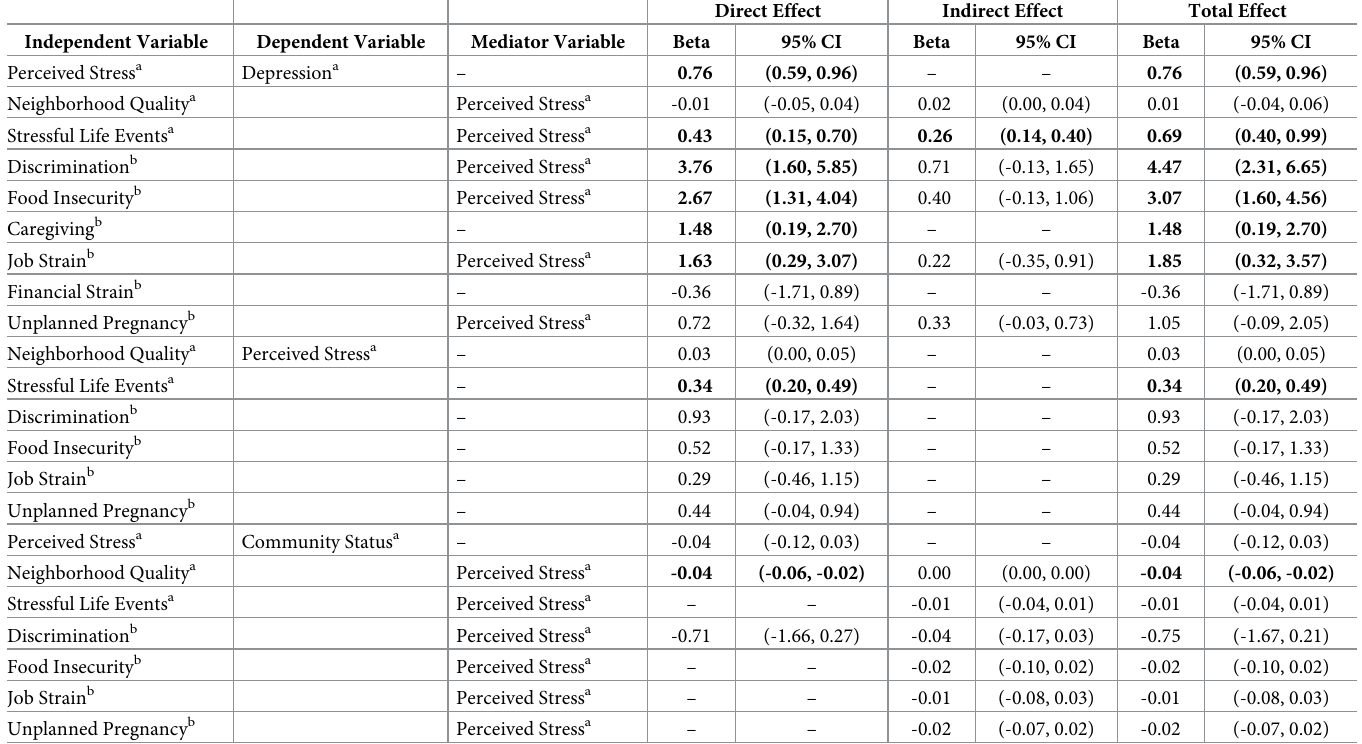
Table 3. Regression coefficients and 95% confidence intervals for direct, indirect, and total effects between psychosocial stress measures in the Chemicals in Our Bodies-2 cohort (N = 510). Model has good fit (RMSEA = 0.04, SRMR = 0.01, CFI = 0.99, TLI = 0.96).